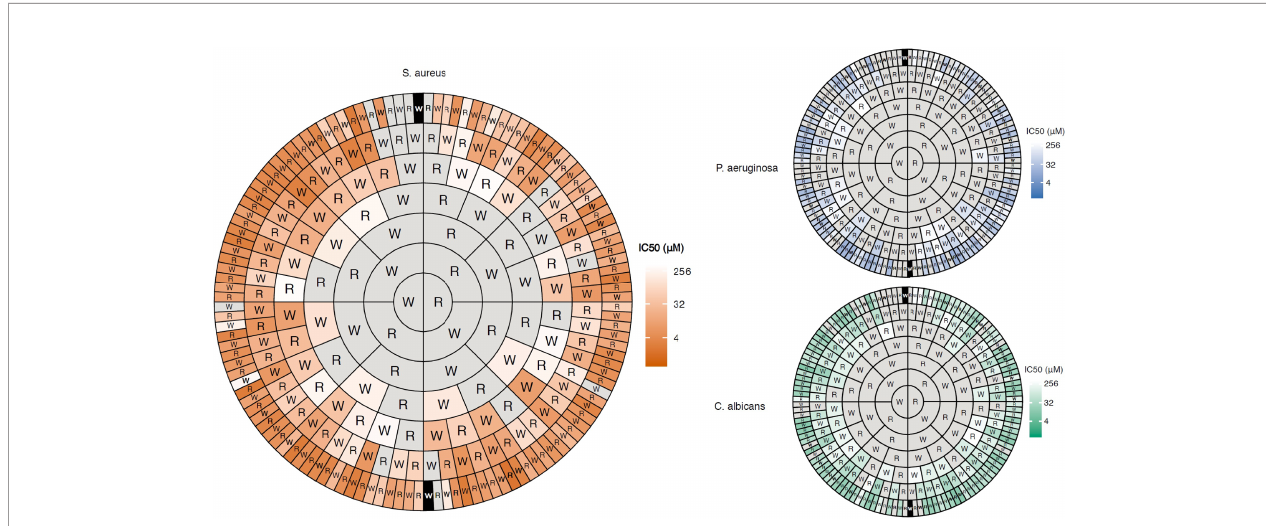
FIGURE 3 | Concentric ring chart representation (Harris-Clark diagram) of the antimicrobial activity of all possible peptides comprised of W and R up to 7 residues long recently developed by Dobson and co-workers (56). The diagram highlights how the antimicrobial activity of the peptides increases with peptide length and that how most peptides are active as heptapeptides if suf fi cient R and W residues are combined in a non-sequence dependent manner. The data also shows how the compounds display a higher activity (shorter peptides required) against Gram-positive bacteria compared to Gram-negative ones and fungi due to differences in cell wall and membrane composition. Figure reproduced from Clark et al. (56) Commun. Biol. 2021 Vol. 4 Issue 1 Pages 1-14 with